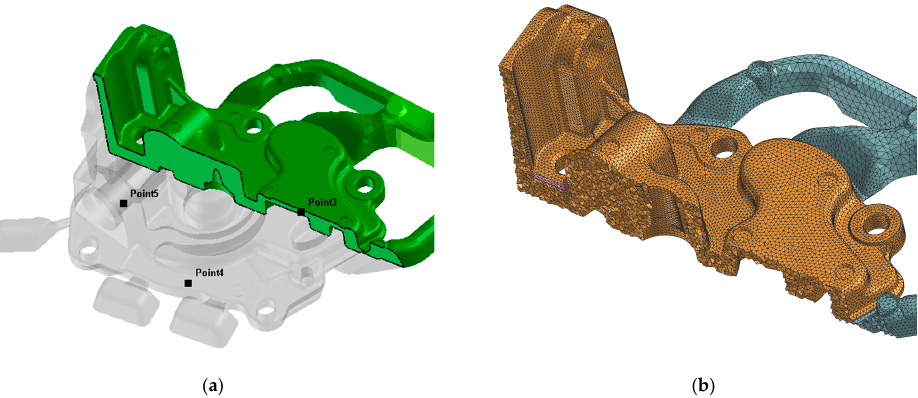
Figure 4. 3D geometry of the casting with marked places of analysis in locations as in Figure 3 ( a ) and fragment of ProCAST 3D FEM mesh for the same part of the casting ( b ). The remaining operating parameters of the machine and peripheral devices (such as fluid temperature settings in the thermostabilization system; velocity profiles of the first pressing phase; plunger positions at the time of switching movement phases; times of mould opening and part ejection, cooling, and other) remained unchanged and were based on settings that gave a satisfactory quality effect in the production of a casting.